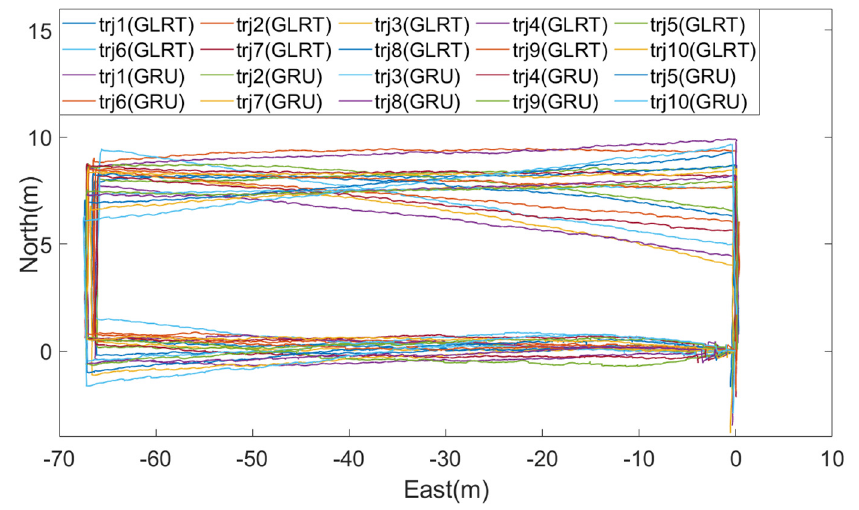
Figure 7. Trajectories obtained by different zero − velocity detection methods . Table 2. Closed loop position error (m) obtained by different zero-velocity detection methods .